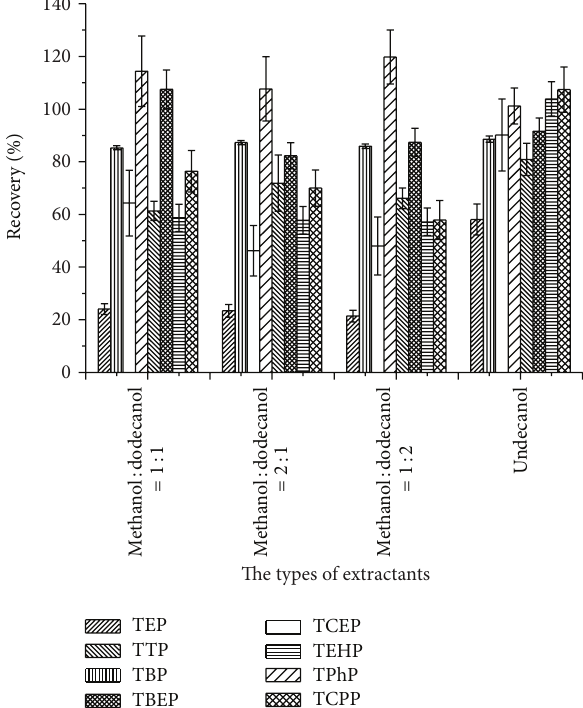
Figure 2: Optimization of